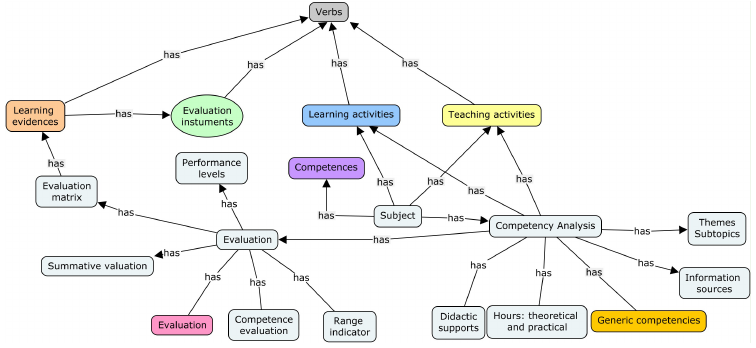
Figure 4. Binary relation